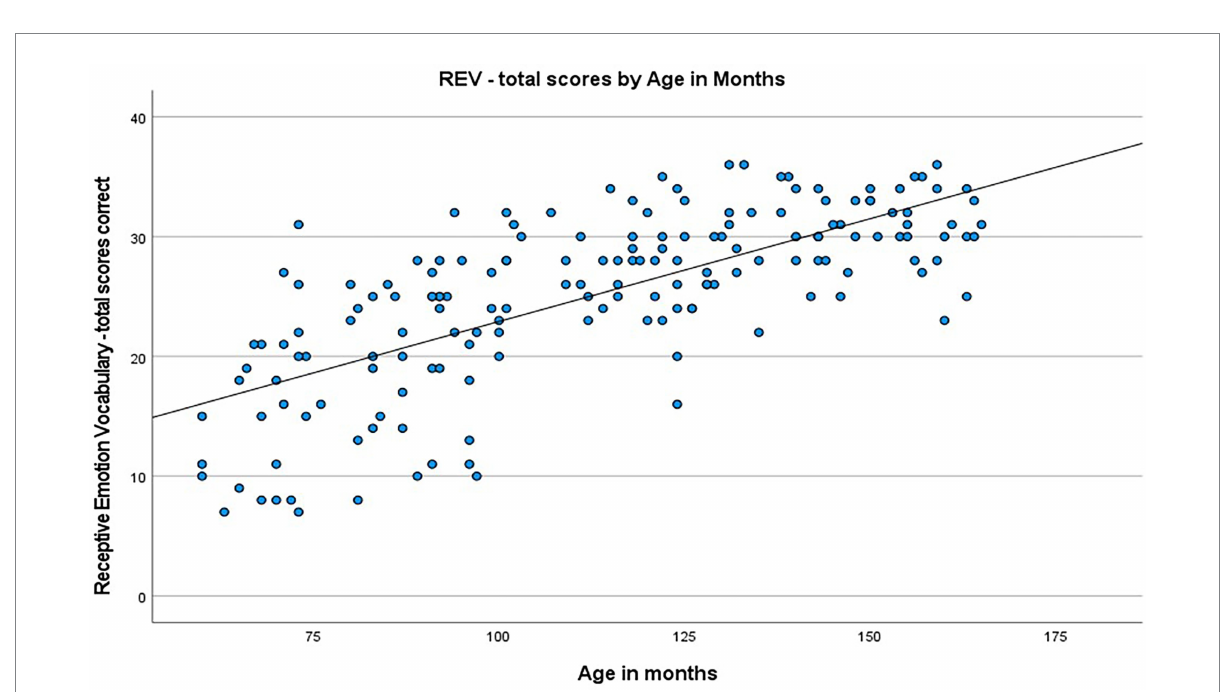
FIGURE 5 Scatterplot showing the correlation between REV scores and age in